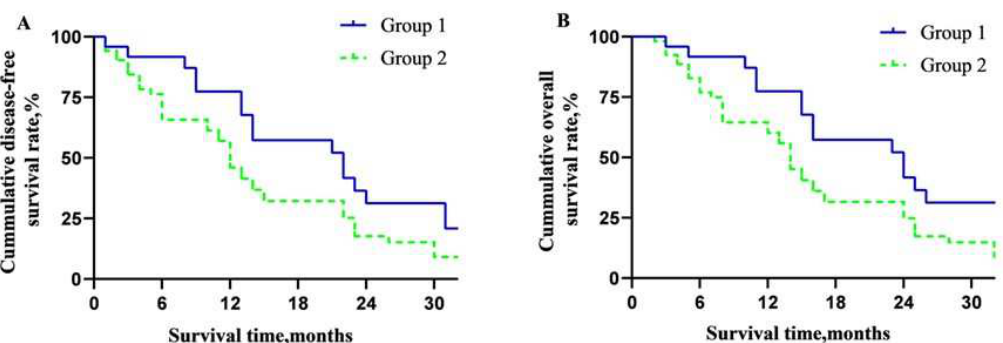
Figure 4. Overall long-term prognosis of the patients in the two groups. ( A ) Disease-free survival curve between the two groups; ( B ) overall survival curve between the two groups.